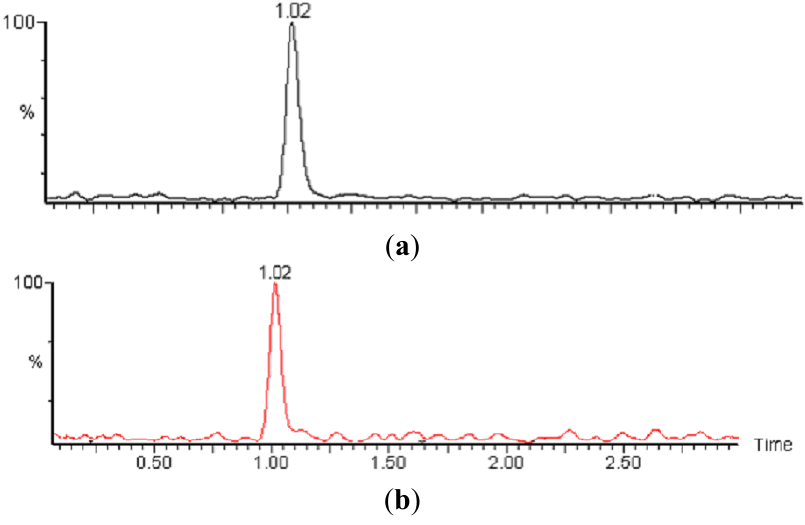
Figure 4. High performance liquid chromatography-electrospray tandem mass spectrometry (HPLC-ESI-MS/MS) of 100 ng/L perchlorate standard. ( a ) Multiple reaction